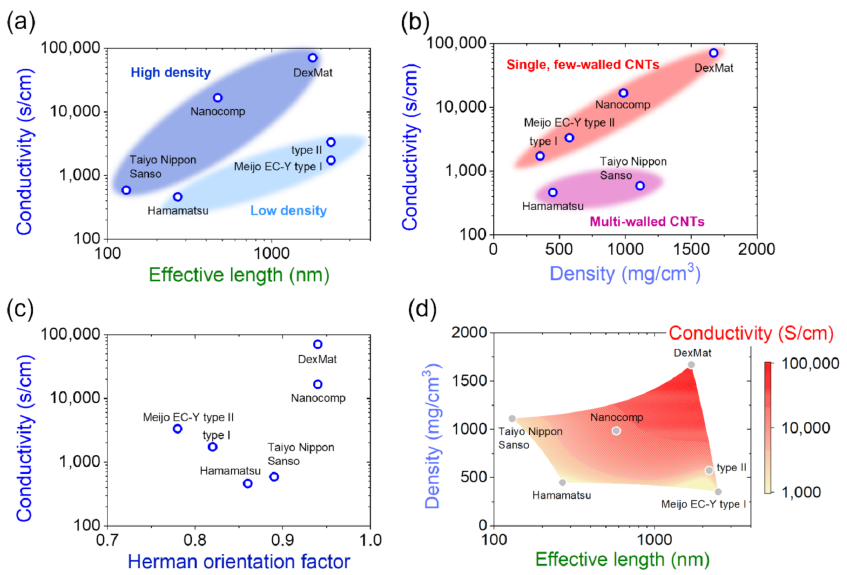
Figure 6. ( a ) Effective length, ( b ) density, and ( c ) Herman orientation factor dependences of the electrical conductivity of yarns. ( d ) 2D contour plot of the yarn